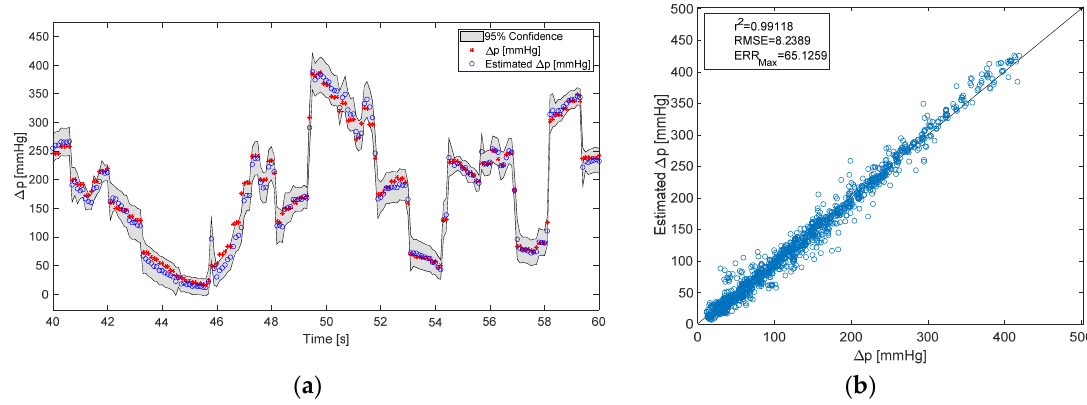
Figure 6. Results of the pressure difference prediction. The estimation is done with a model that is trained on the same viscosity as the test signal. (a) Time series of the true and predicted flow rate with confidence intervals; (b) A scatter plot with fitness measures of the estimated vs measured pressure difference.